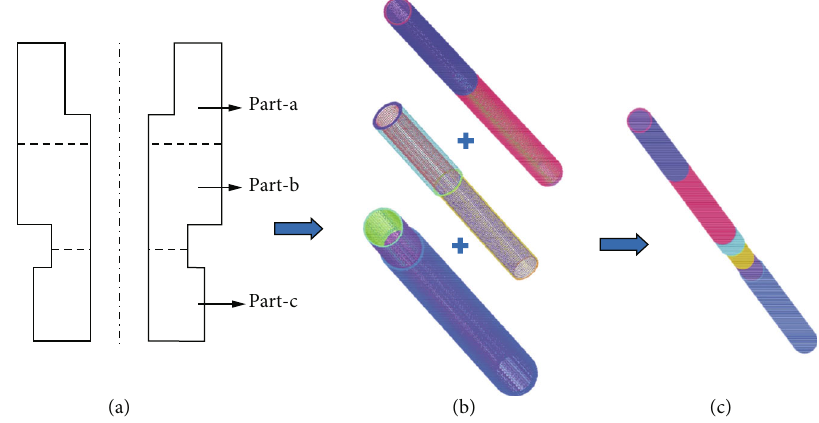
Figure 6: Con fi guration of the annulus with varied radial sizes and its meshed structure